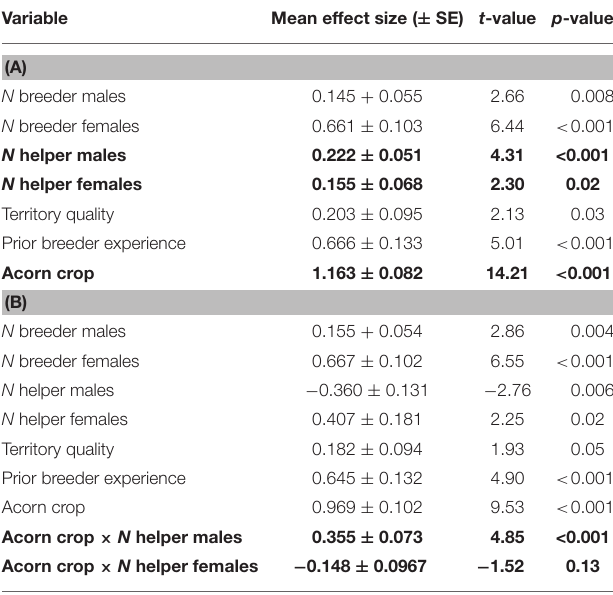
TABLE 1 | Linear regressions of factors influencing reproductive success of groups (A) without interactions between number of helpers and the acorn crop and (B) including these